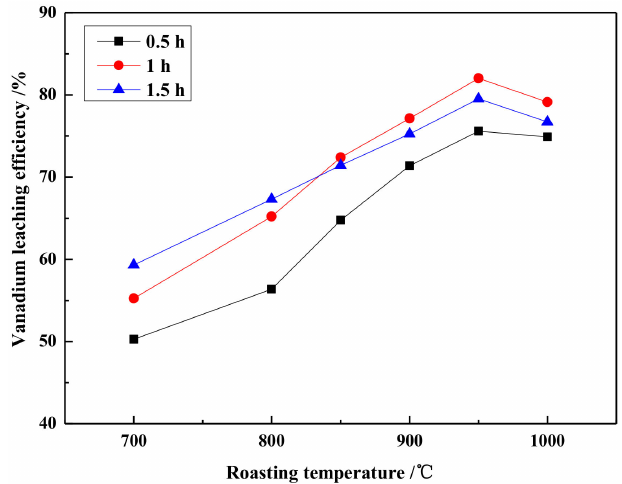
Figure 4. Effect of roasting temperature and time on vanadium leaching